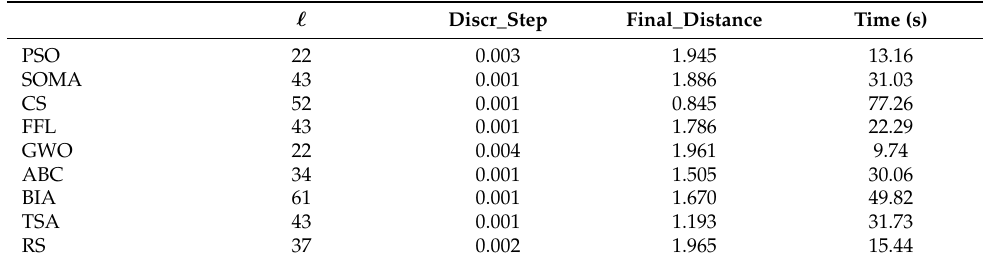
Figure 6. Checkpoints of each algorithm automatic parameter tuning with maxFES = 2500. Red lines are values of final _ distance and blue ones show the maximum value of Manhattan distance. Grey dashed lines show values thresholds. Table 7. The best results of evolutionary algorithms with a value of maxFES = 2500.